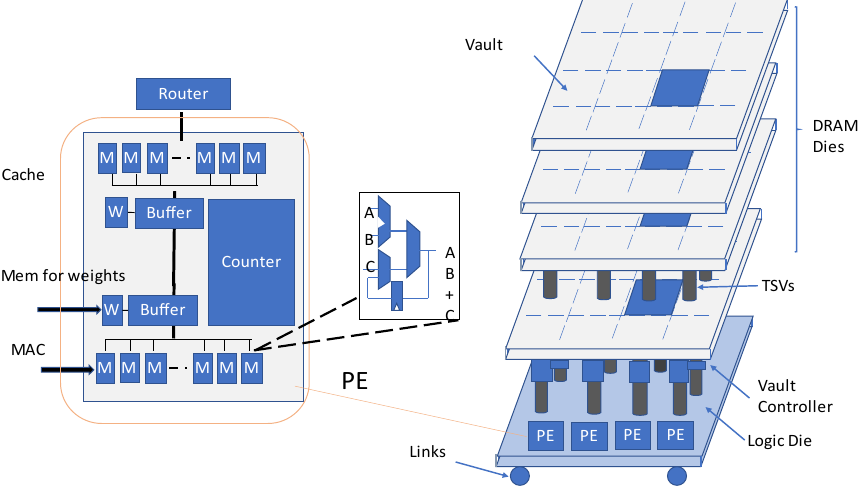
Figure 3. Neurocube accelerator with detailed PE architecture. TSV: through silicon via [4].